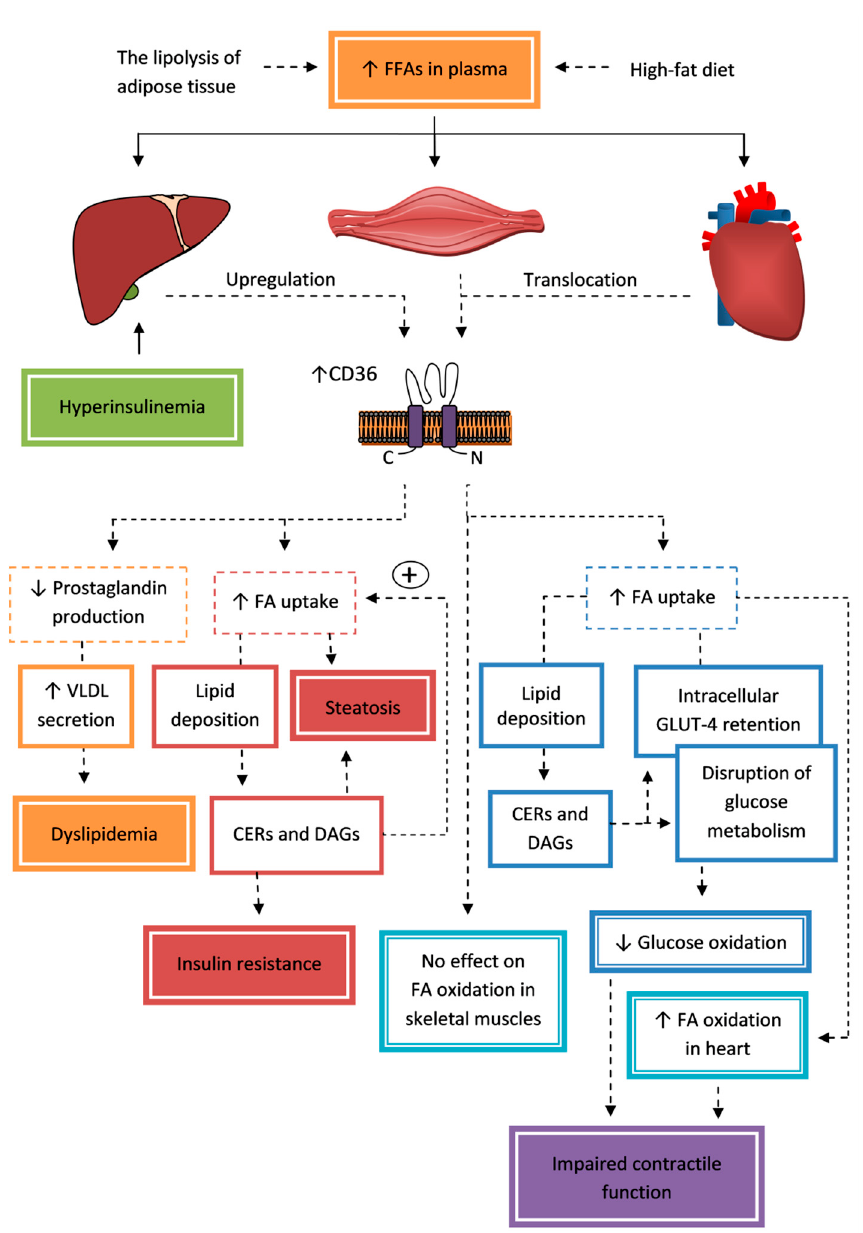
Figure 2. The contribution of CD36 to the pathogenesis of insulin resistance in the liver, muscle, and the heart. Increased free fatty acid (FFA) concentrations in plasma are a factor initiating upregulation and translocation of CD36 with an increase in this transporter expression in the plasma membrane for the liver and myocytes. This leads to an increase in fatty acid (FA) influx via CD36 with pathological accumulation of triacylglycerols (TAGs), diacylglycerols (DAGs), and ceramides (CERs) initiating lipotoxicity and insulin resistance. A typical feature of an insulin-resistant liver is steatosis, in which accumulating lipids antagonize insulin signaling, re-increase CD36 expression in the cell membrane, disrupt mitochondrial function, and increase TAG accumulation. However, increased expression of CD36 in hepatocytes also stimulates the removal of FAs by very-low-density lipoprotein (VLDL) secretion, but this is associated with the worsening of dyslipidemia. Skeletal and cardiac myocyte overexposure to lipids results in glucose transporter type 4 (GLUT-4) being entrapped in non-endosomal storage and the translocation of CD36 to the sarcolemma associated with excessive FA transport and lipid accumulation interfering insulin signaling by a decreased glucose transport and its incorporation to glycogen. Moreover, in cardiomyocytes, FA oversupply changes the expression of genes associated with FA and glucose utilization. Ultimately, these actions result in a transition to energy from FAs instead of glucose and contractile dysfunction.